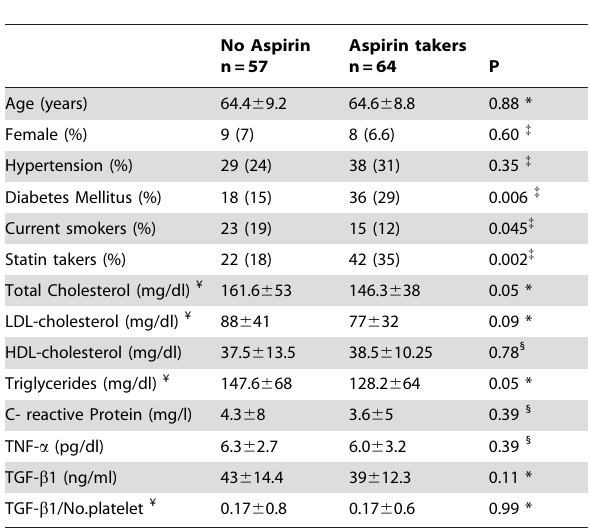
Table 1. Clinical characteristics of the study groups.